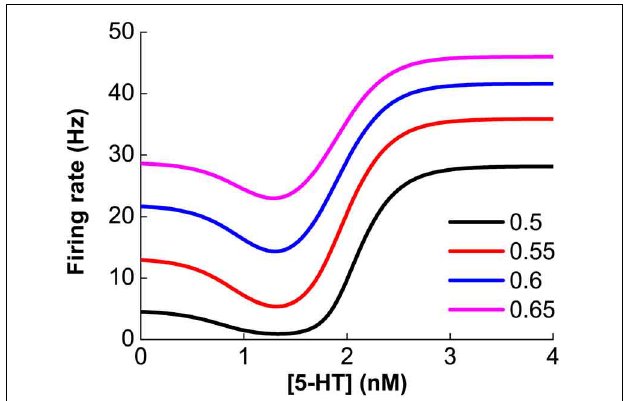
FIGURE 4 | Modulation of DA and 5-HT on a network consisting of Pyr1-type (D1 + 5-HT1A) and Int1 (D1 + 5-HT1A) neurons. (A) Firing rate time course of pyramidal cells with [DA] = 7nM and [5- HT ] = 0.3nM (dotted) or 2nM (solid). (B) Oscillation frequency decreases with increasing [DA]. [5- HT ] = 0.3nM (dotted) and 2nM